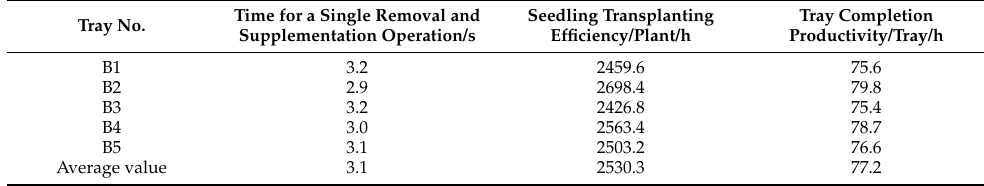
Table 4. Data table of the transplanting test efficiency. Tray